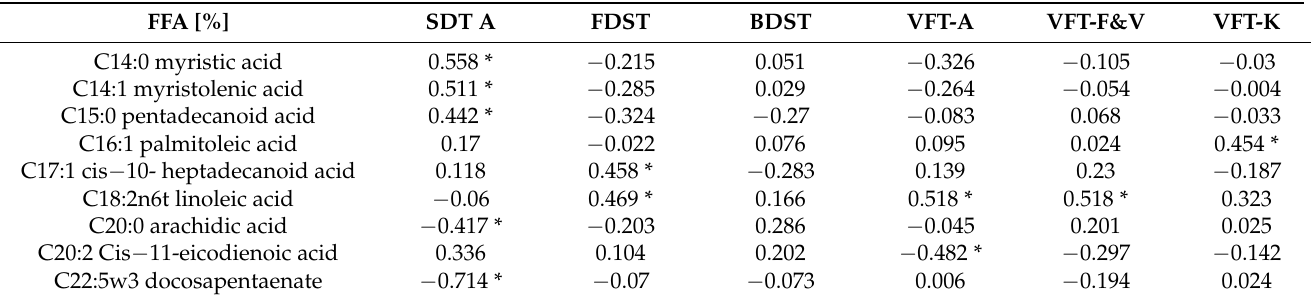
* p < 0.05 statistically significant correlation matrix (Spearman’s rank correlation); TMT A—Trial Making Test A, SDT A—Stroop Dots Trial A, FDST—Forward Digit Span Test, BDST—Backward Digit Span Test, VFT-A—Verbal Fluency Test-Animals, VFT-F&V—Verbal Fluency Test-Fruits and Vegetables, VFT-K–Verbal Fluency Test-Letter “K”. Table 5. The correlations between FFAs and the results of neuropsychological tests obtained after 6 months (SDT A,